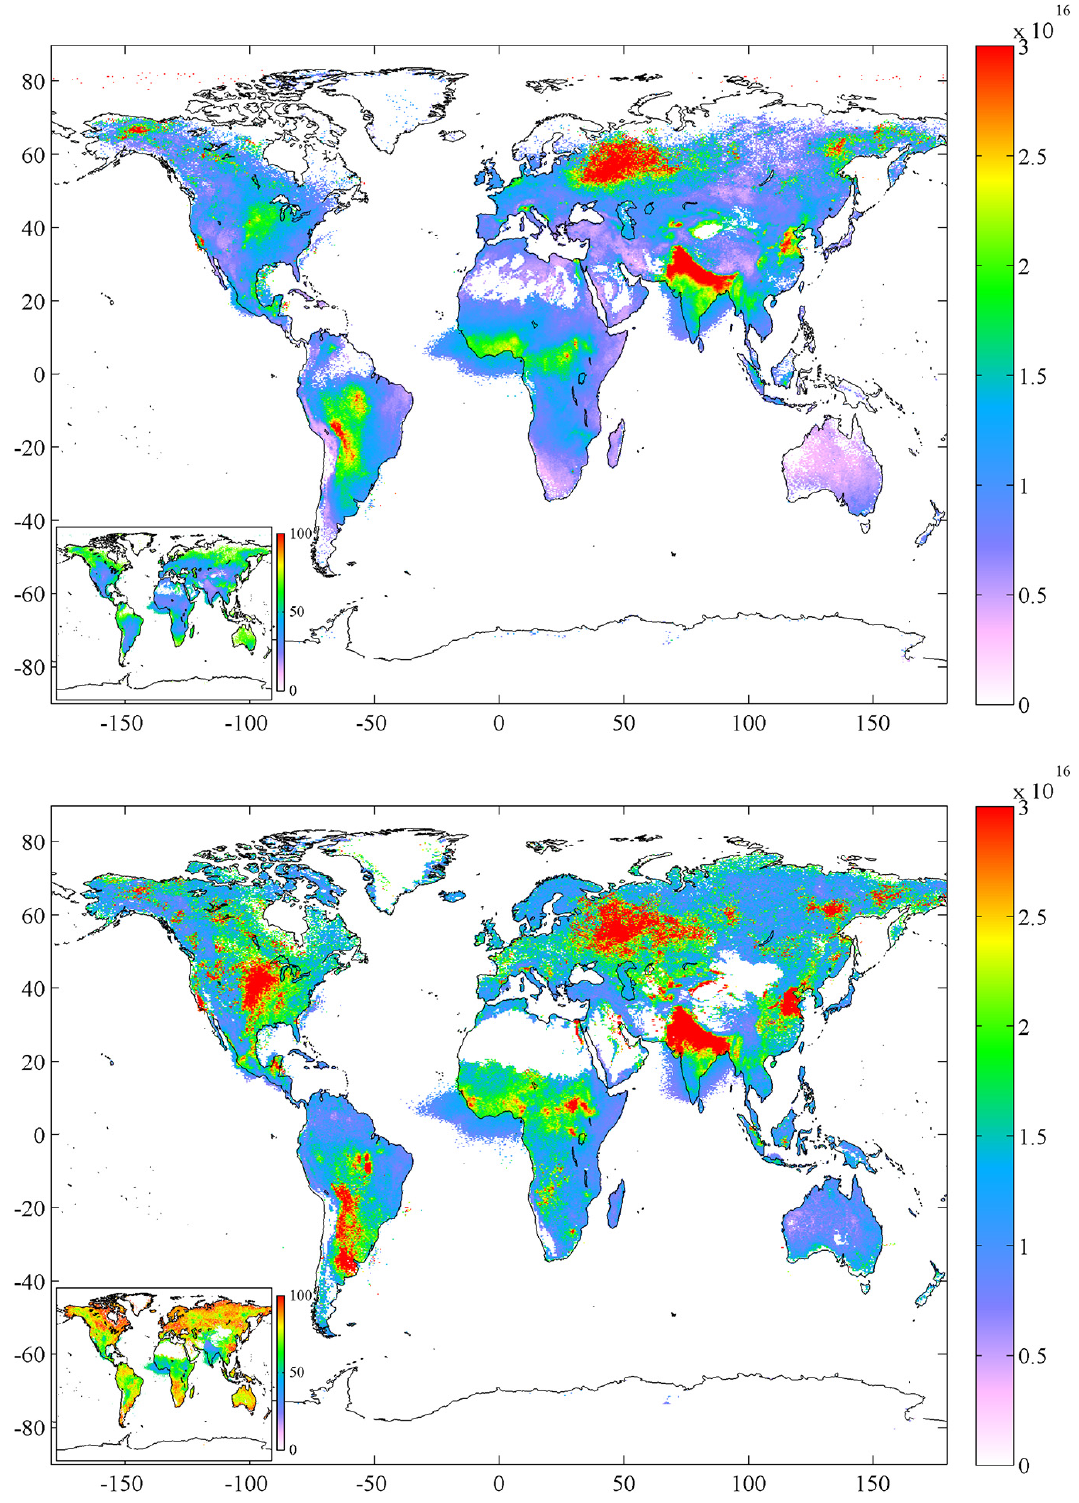
Fig. 10. NH 3 total columns (moleccm − 2 ) and relative error (bottom-left inset, %) distributions for five years of IASI measurements (1 November 2007 to 31 October 2012), in 0.25 ◦ × 0.5 ◦ cells for the morning (top panel) and evening (bottom panel) overpasses. The NH 3 distributions are a mean of all measurements within a cell, weighted by the relative retrieval error following Eq. (3). The error distributions are a weighted mean of the relative error of all observations within a cell, following Eq.